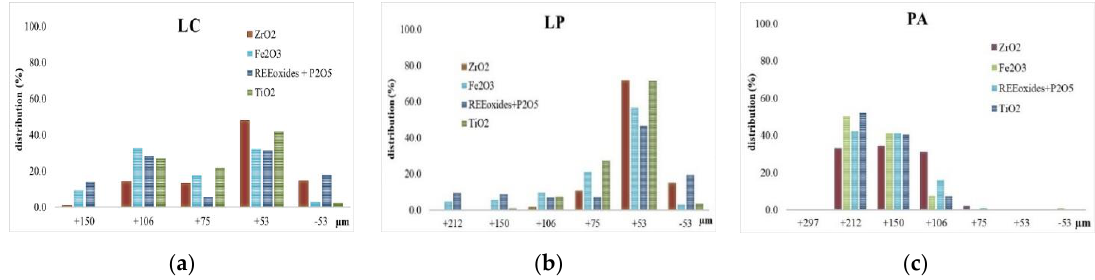
Figure 9. Selected major elements in terms of oxides (ZrO 2 , Fe 2 O 3 , REE+P 2 O 5 and TiO 2 ) of raw material by size fraction of LC ( a ), LP ( b ) and PA ( c ) samples, according to the XRF results.